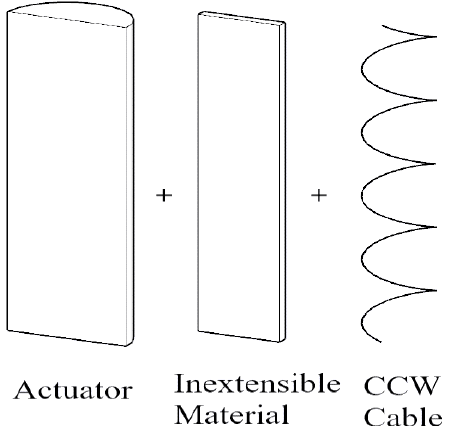
Figure 2. Twisting design of soft pneumatic actuator.